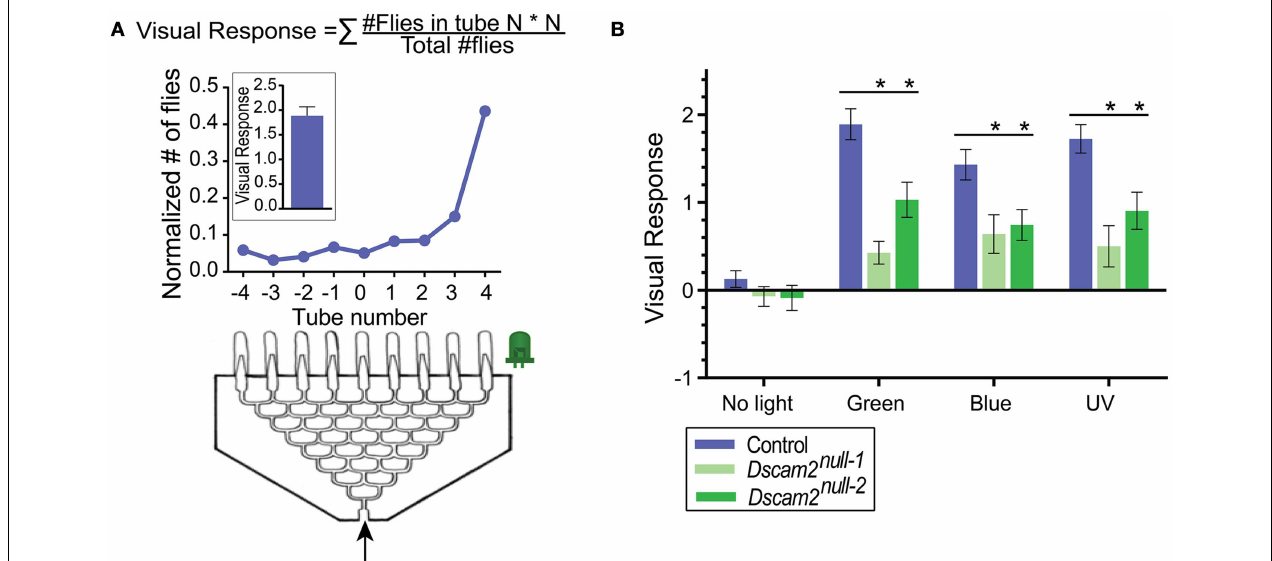
FIGURE 2 | Dscam2 mutants have a reduced phototaxic response in the startle-induced phototaxis assay. (A) Phototaxis assay. Flies ( ∼ 30 per maze) enter the maze and end up in one of the nine end tubes ( − 4 to 4). The normalized distribution of flies from one maze is shown in the line graph. This was calculated by dividing the number of flies in each tube by the total. The visual response formula is at the top of the panel and the response of the maze shown is plotted in the